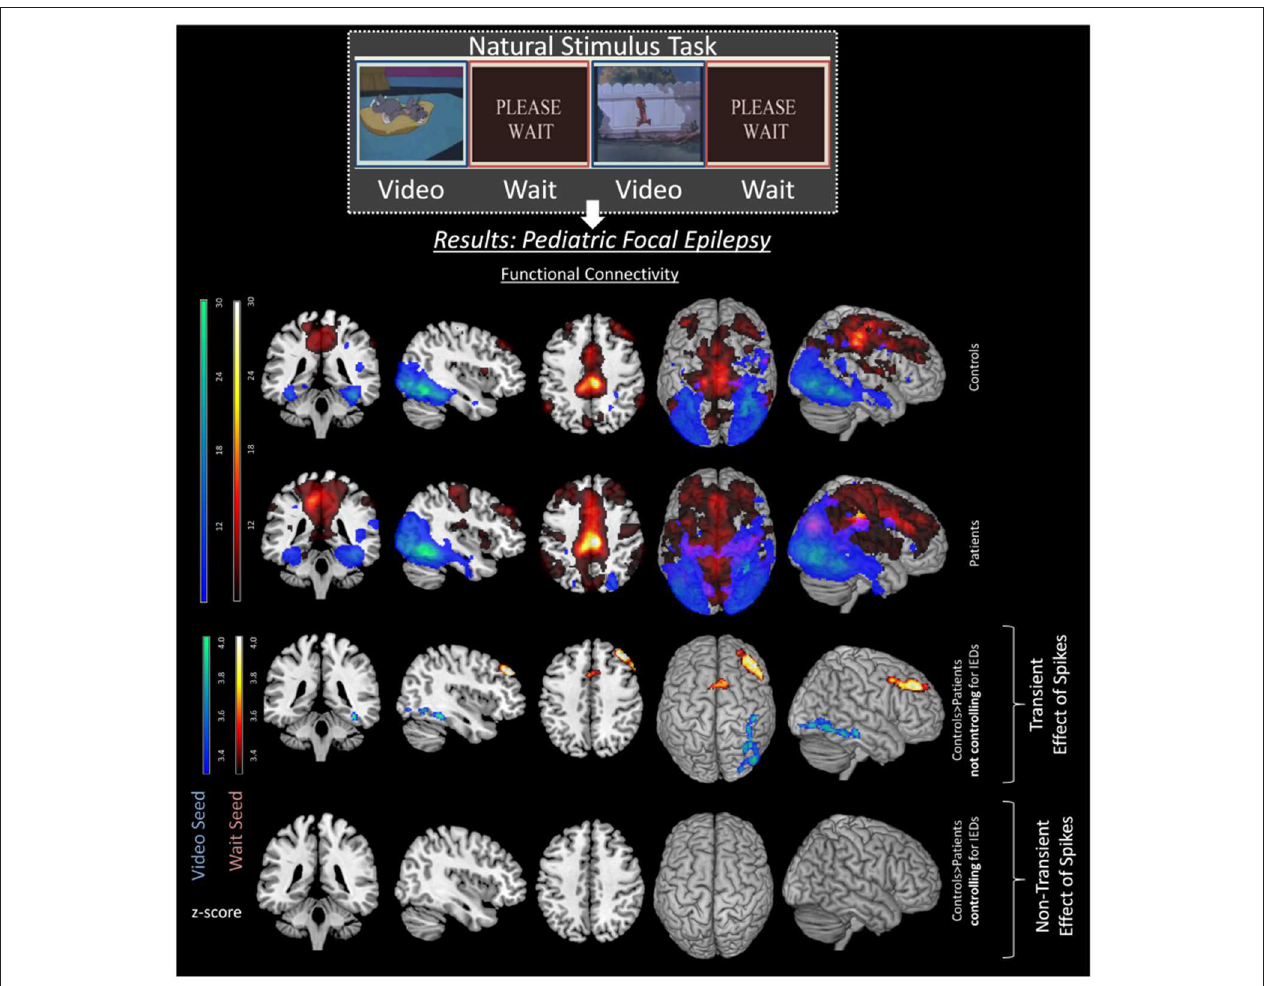
FIGURE 2 | Transient effects of IEDs in pediatric focal epilepsy patients. Image with permission Shamshiri et al. (22) illustrating the effects of spikes on FC networks of a resting state task. Differences between controls (top row) and patients (second row) can be seen in the third row. These differences are including both transient and long-term effects of spikes as spikes are not controlled for in the analysis. However, once the transient effects of spikes are accounted for, the group differences disappear (fourth row), emphasizing the effect of IEDs on